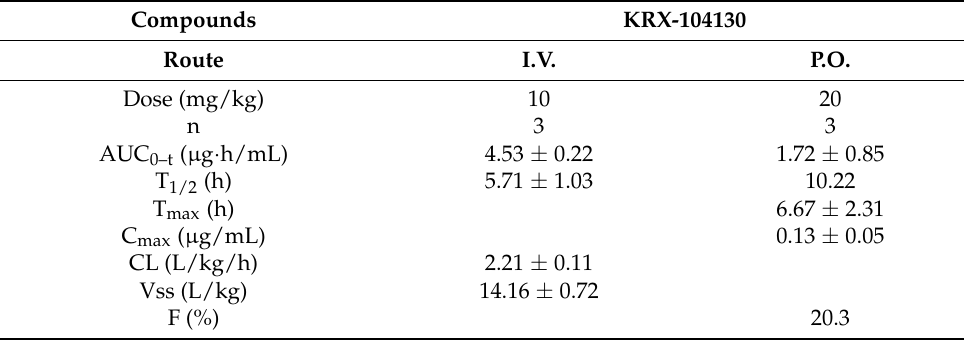
Table 1. In vivo mouse experimental results of